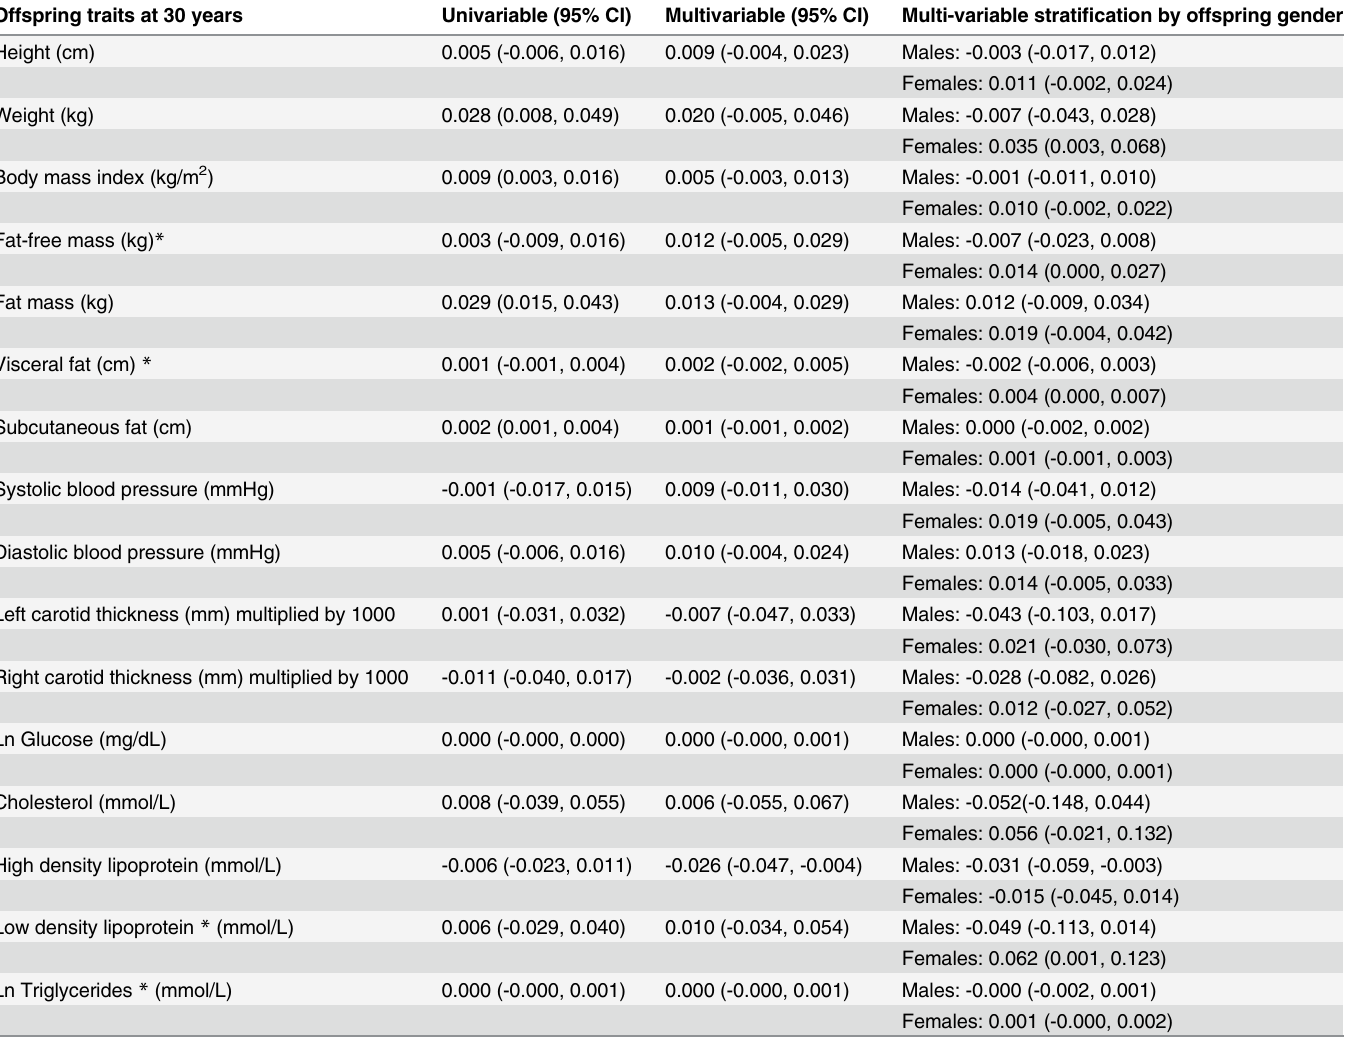
Table 2. Regression analysis results with birth interval as a continuous